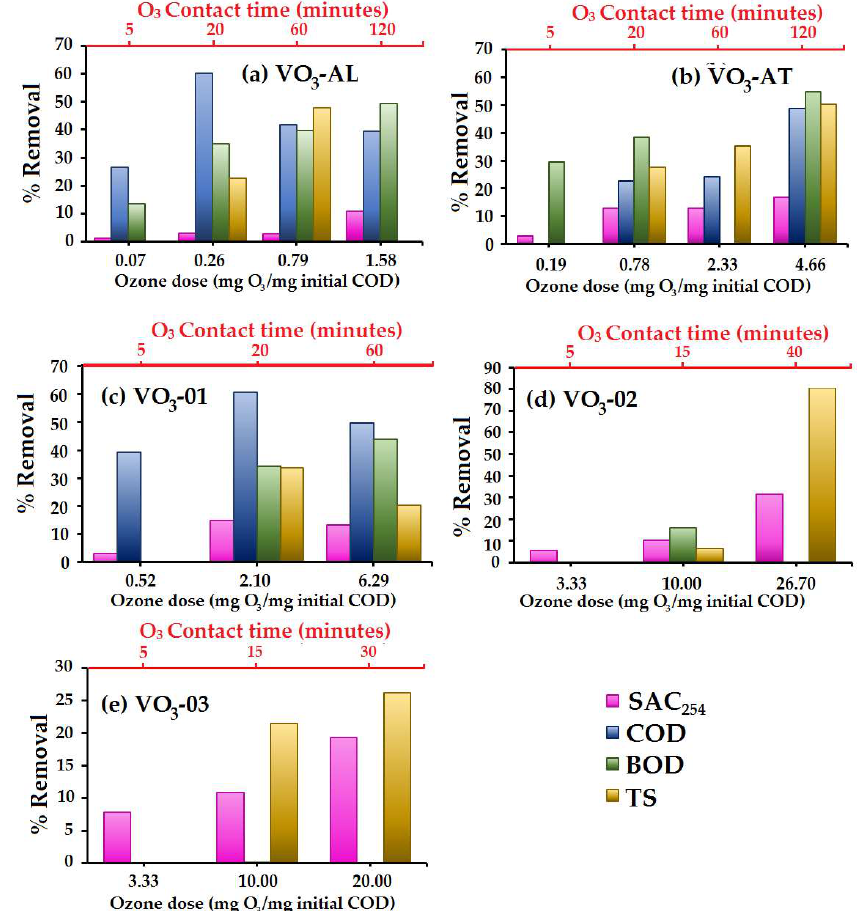
Figure 3. Removal (%) of COD, BOD 5 , Spectral Absorption Coefficient at 254 nanometers (SAC 254 ) and total solids (TS) upon ozonation of water at different ozone doses and O 3 contact time.